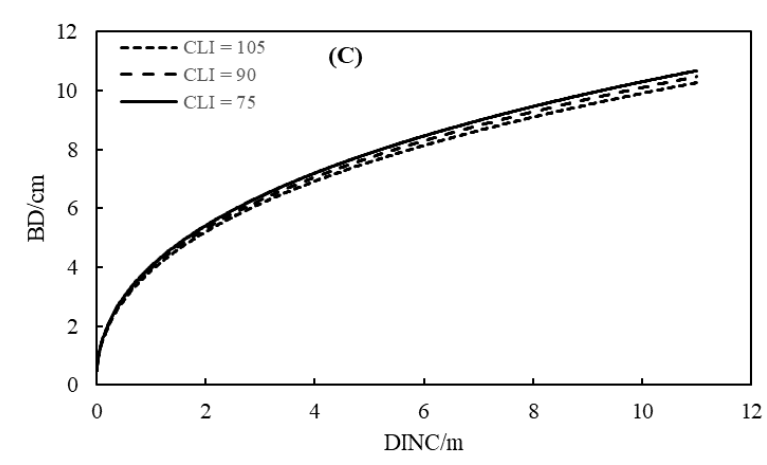
Figure 4. Effect of DBH ( A ), HT ( B ), and the CLI ( C ) on branch diameter with an increasing DINC within the entire crown for the planted Korean pine.